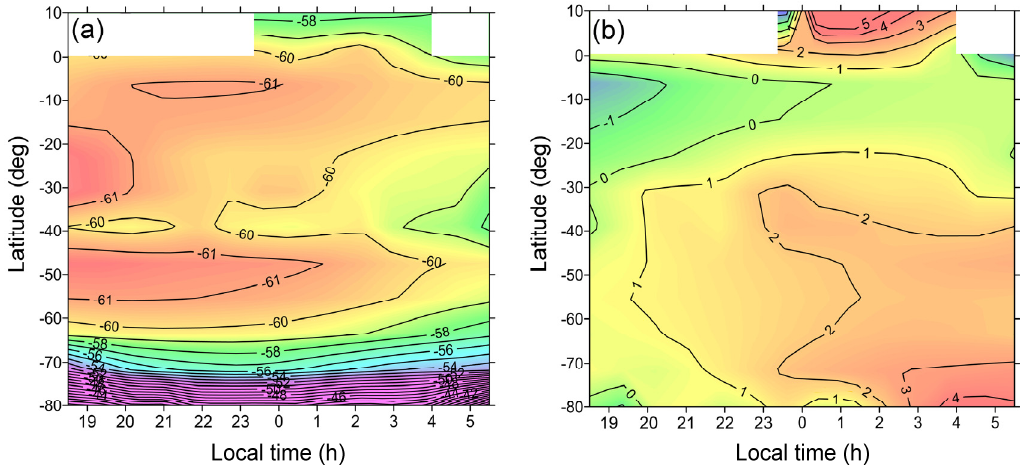
Figure 5. Mean zonal ( a ) and meridional ( b ) speed in the lower clouds as a function of local time and latitude. Areas where no velocity vectors were available are left blank.